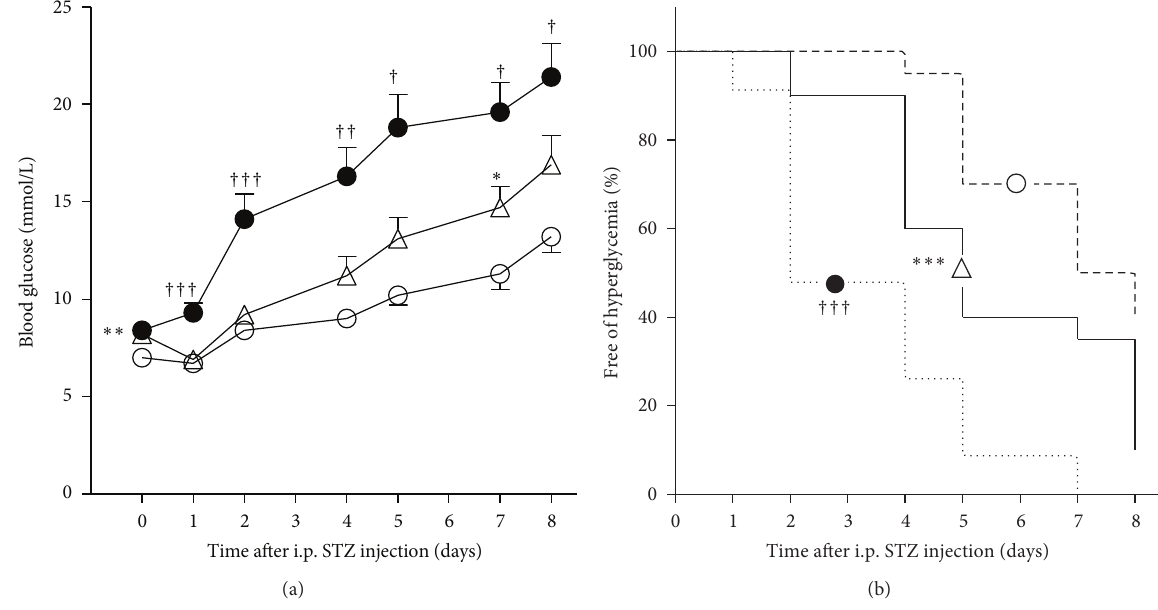
F 2: Streptozotocin sensitivity at 12 weeks of age in heterozygous C3H-11 NSY ( and homozygous C3H-11 NSY ( intraperitoneal injection of streptozotocin at 175mg/kg body weight. Blood glucose concentrations are presented as mean percentage of animals free of hyperglycemia (blood glucose level compared with C3H and log-rank test for